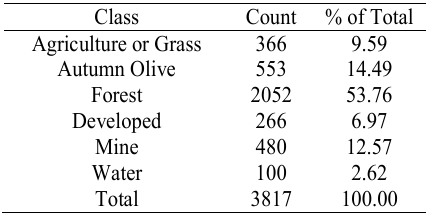
Table 2. Numbers of training data points by classified